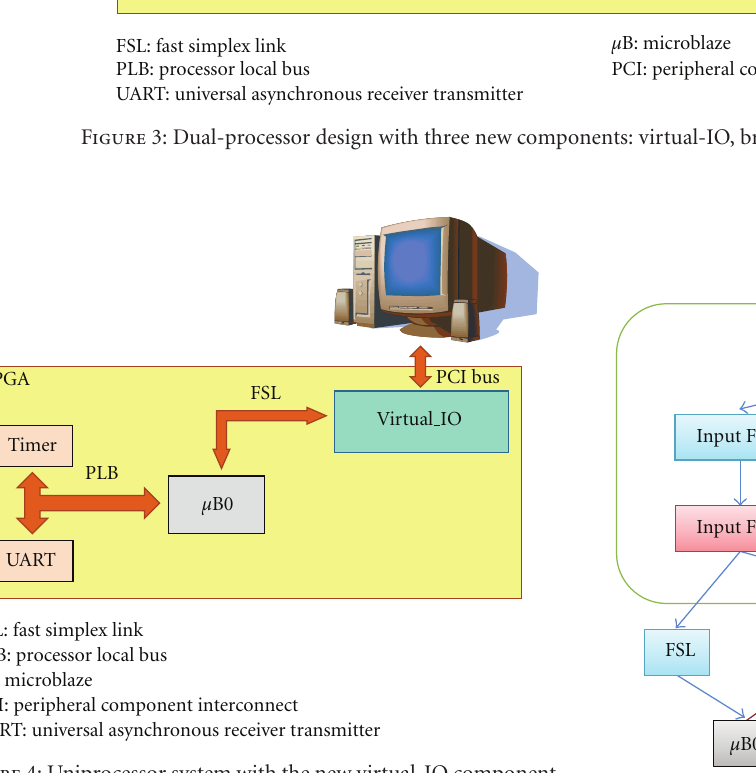
Figure 4: Uniprocessor system with the new virtual-IO component